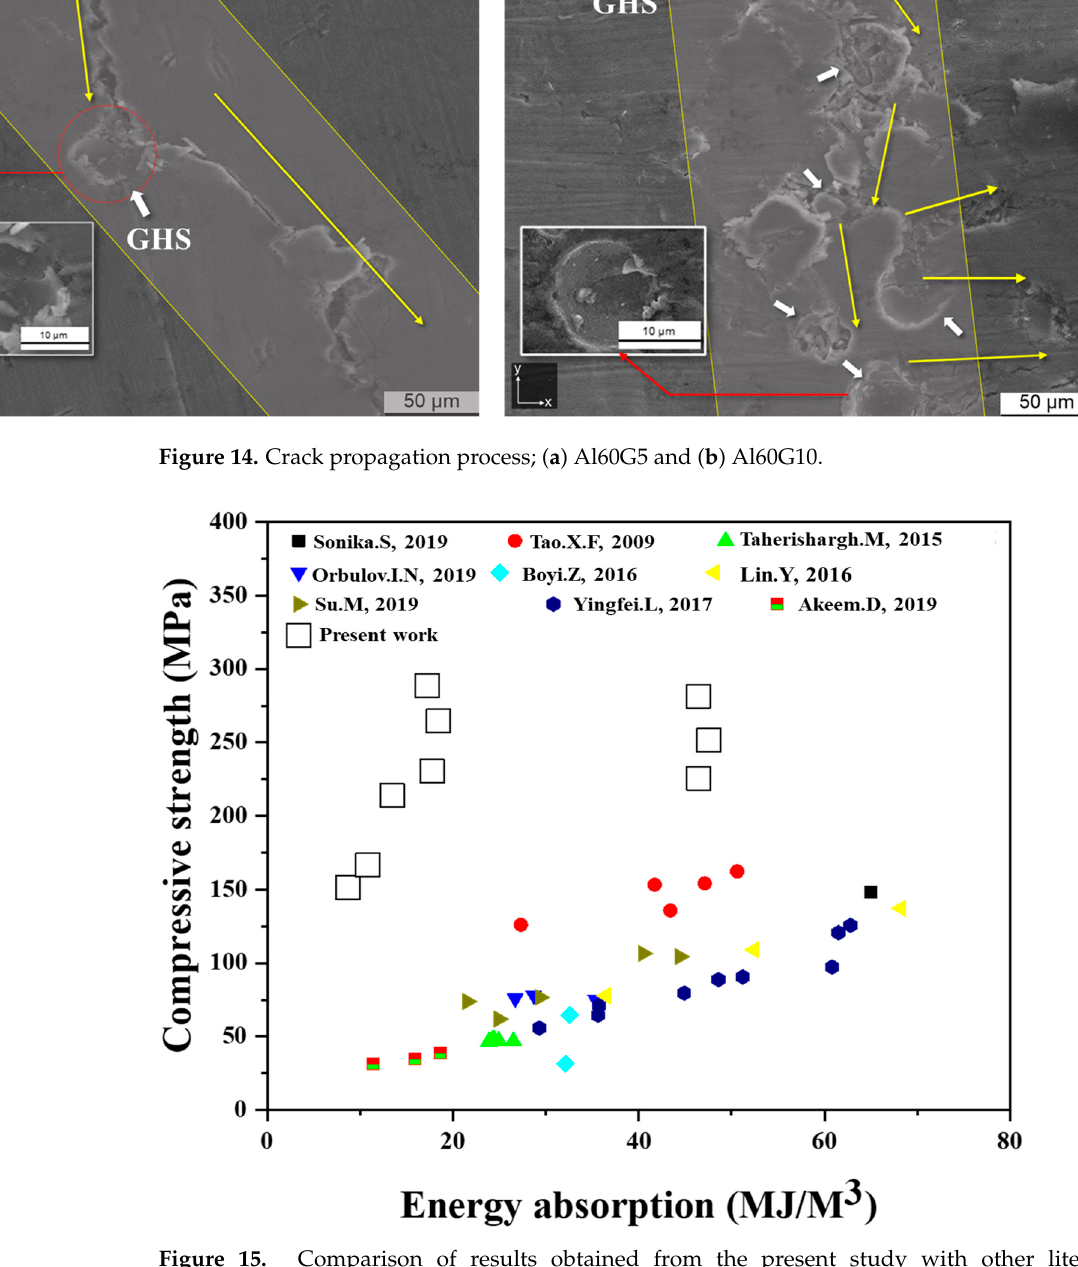
Figure 14. Crack propagation process; ( a ) Al60G5 and ( b ) Al60G10.